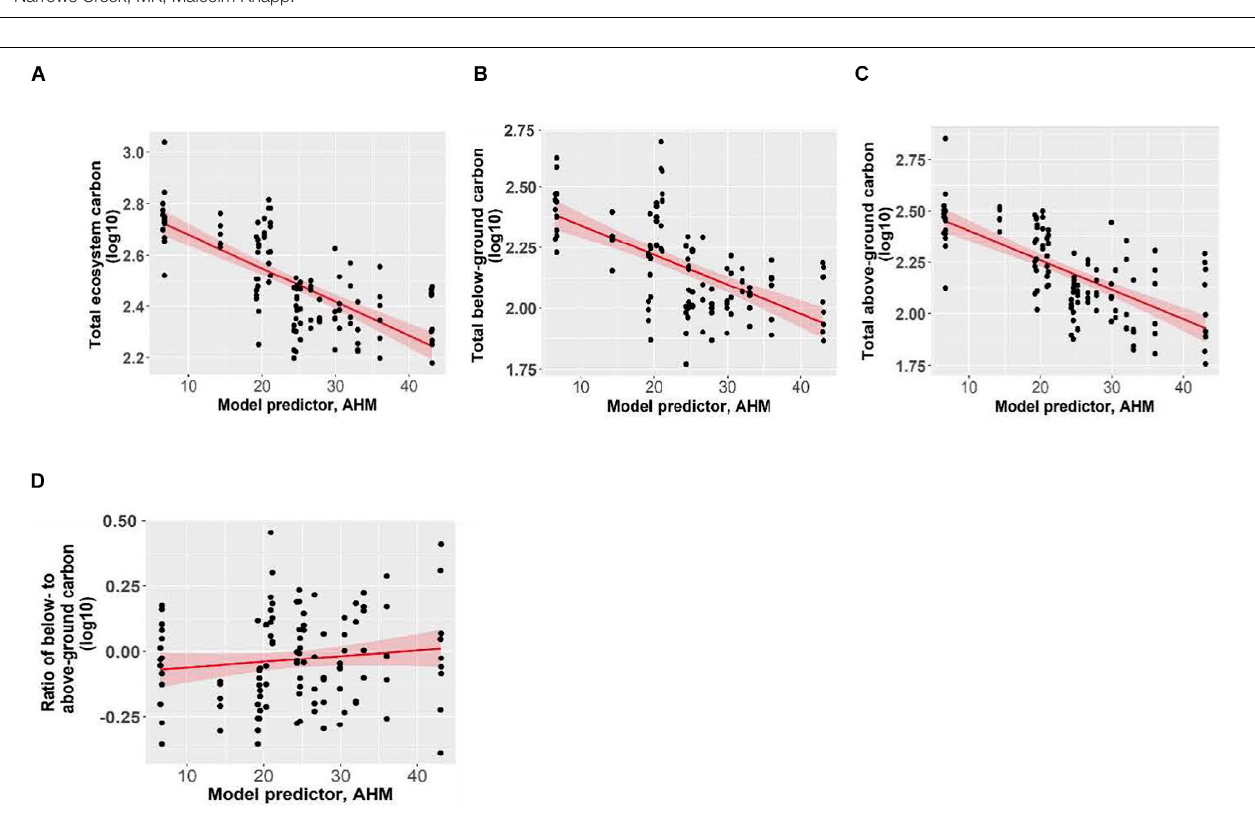
FIGURE 4 | Distribution of carbon amongst the major pools, for the nine study locations. The locations are arranged in order of decreasing summer heat: moisture index (SHM), shown by the blue line. VEN, Venables; TB, Two-bit Creek, PH, Peterhope Lake; JAF, Jaffray; RF, Redfish Creek; AF, Alex Fraser; JP, John Prince; NAR, Narrows Creek, MK, Malcolm Knapp.